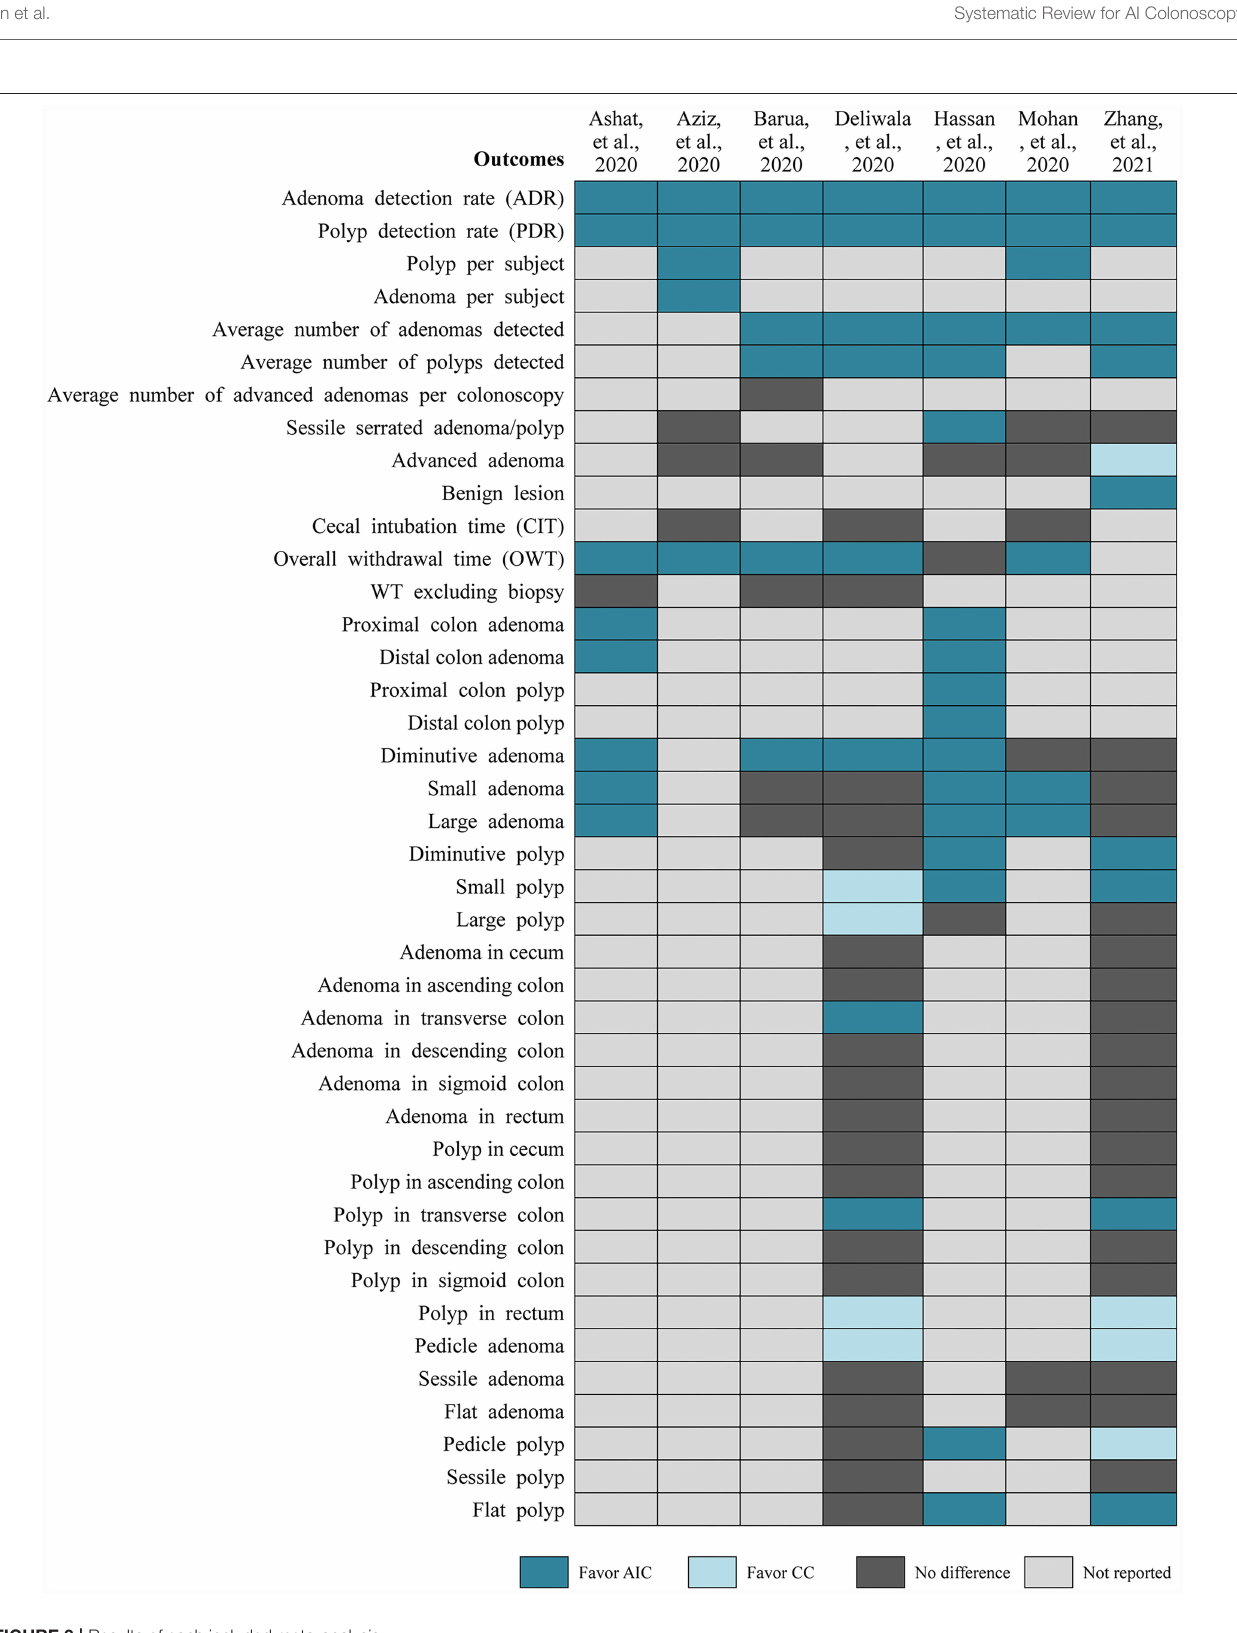
FIGURE 3 | Results of each included